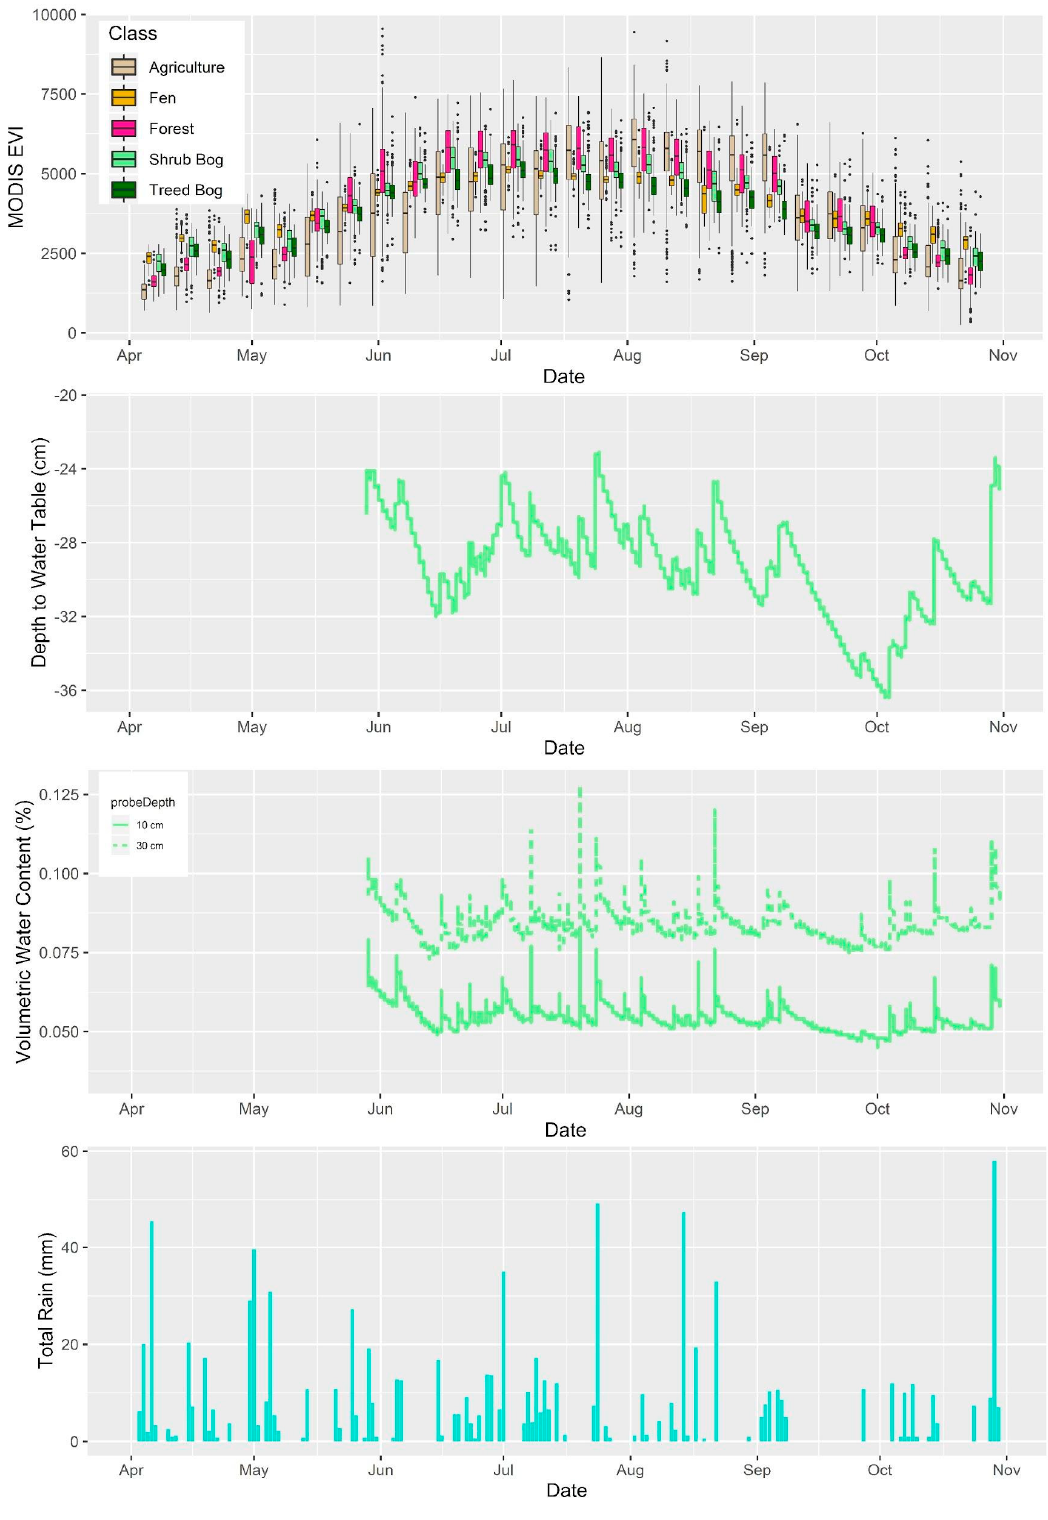
Figure 2. Enhanced vegetation index (EVI) from MODIS Aqua and Terra, depth to water table from the surface of the peatland, soil moisture at two depths, and rain—all measured over the 2017 growing season. Water table and soil moisture are measured at a meteorological station located in the shrub bog area of Alfred Bog. These measurements were commenced in late May 2017. Rain was measured at Environment and Climate Change Canada’s weather station in St. Albert, Ontario, approximately 40 km south east of Alfred Bog.